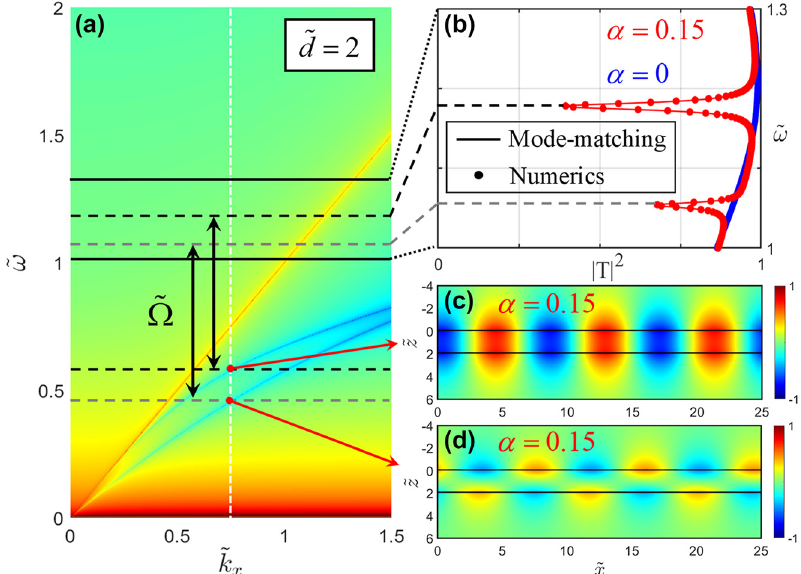
Figure 2: The dynamical SWs excitation mechanism. (a) Dispersion relation of surface modes at a double-sheet system, calculated using the matrix M . The black double arrows indicate the ̃ Ω . (b) Transmittance spectra for two temporal sheets with and without excitation mechanism with time-gratings at the modulation frequency ̃ = 0 . 75 [white vertical dashed line in (a)]. Here we used ̃ d = 2, 𝜀 = 𝜀 = 𝜀 = 1, modulation ( 𝛼 = 0 . 15 and 0) at fixed in-plane wavevector k ( ) 1 2 3 x ̃ Ω ≈ ̃ E 0 . 6, and ̃𝛾 ≈ 0 . 01. Solid line: Mode-matching result. Dots: Numerical result from COMSOL. (c, d) Electric field distributions of the x , − 1 ̃ Ω ≈ 0 . 6. Symmetric symmetric and anti-symmetric surface modes under time-modulation of its Drude weight with modulation frequency ≈ 1 . 176 and anti-symmetric (odd) mode at frequency ̃𝜔 ≈ 1 . 056 are (even) mode at frequency ̃𝜔 0 + 0 −